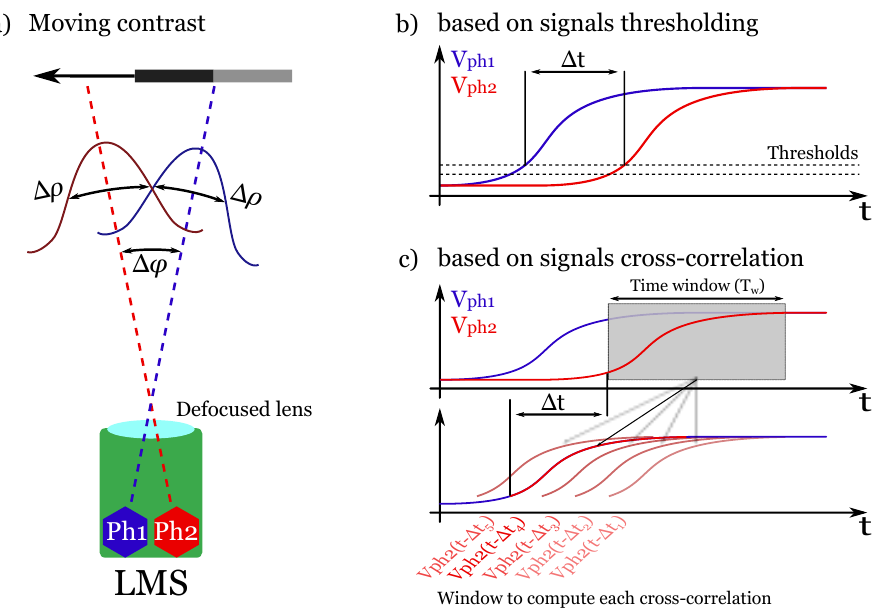
Figure 3. ( a ) Optics geometry of a LMS. A defocused lens confers an inter-pixel angle ∆ ϕ between the optical axes of two adjacent pixels Ph1 (blue) and Ph2 (red) and an acceptance angle ∆ ρ given by the width of the Gaussian angular sensitivity at half height. The output signals V ph 1 and V ph 2 coming from pixels Ph1 and Ph2, respectively, are naturally delayed by a “time-of-travel” ∆ t when a contrast is moving in front of them (Figure 3b,c). The OF can therefore be computed with Equation (1). ( b ) Principle of the time-of-travel algorithm based on signal thresholding: the time delay ∆ t is computed when both signals reach a given hysteresis threshold [4,7,8,29]. ( c ) Principle of the time-of-travel algorithm based on signals’ cross-correlation: the time delay ∆ t is computed as the time delay giving the maximum cross-correlation coefficient (cid:36) between the delayed and non-delayed signal (see Figure 2 in [26] for details). Note that for simplicity, the time-of-travel computation is shown here using the raw signals V ph 1 and V ph 2 , but it is actually computed after band-pass filtering these signals (see